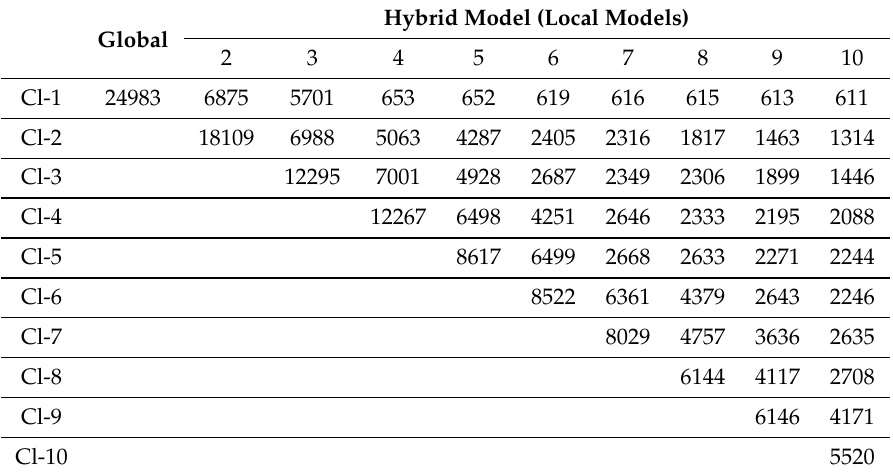
Table 1. Number of samples in each created